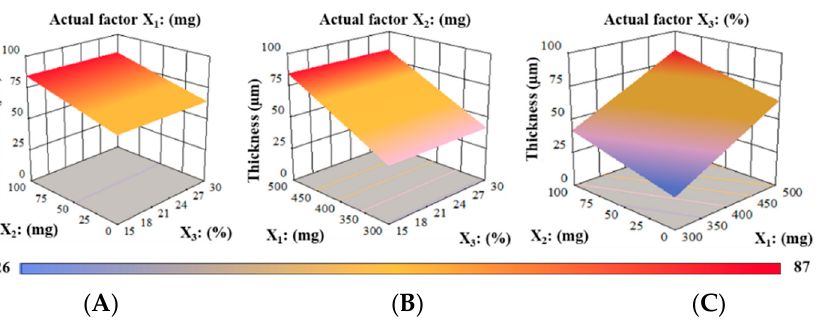
Figure 2. 3D surface models describing the influence of ( A ) PUL (X 1 ), ( B ) MTX (X 2 ), and ( C ) PG (X 3 ) on film thickness (Y 1 ) of